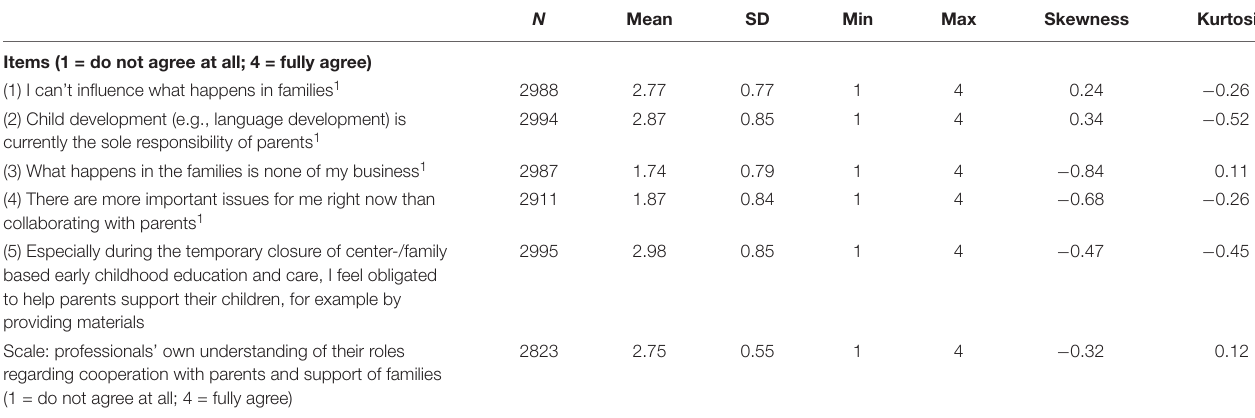
TABLE 2 | Descriptive data of items used to compute a scale on professionals’ own understanding of their roles regarding cooperation with parents and support of families. N Mean SD Min Max Skewness